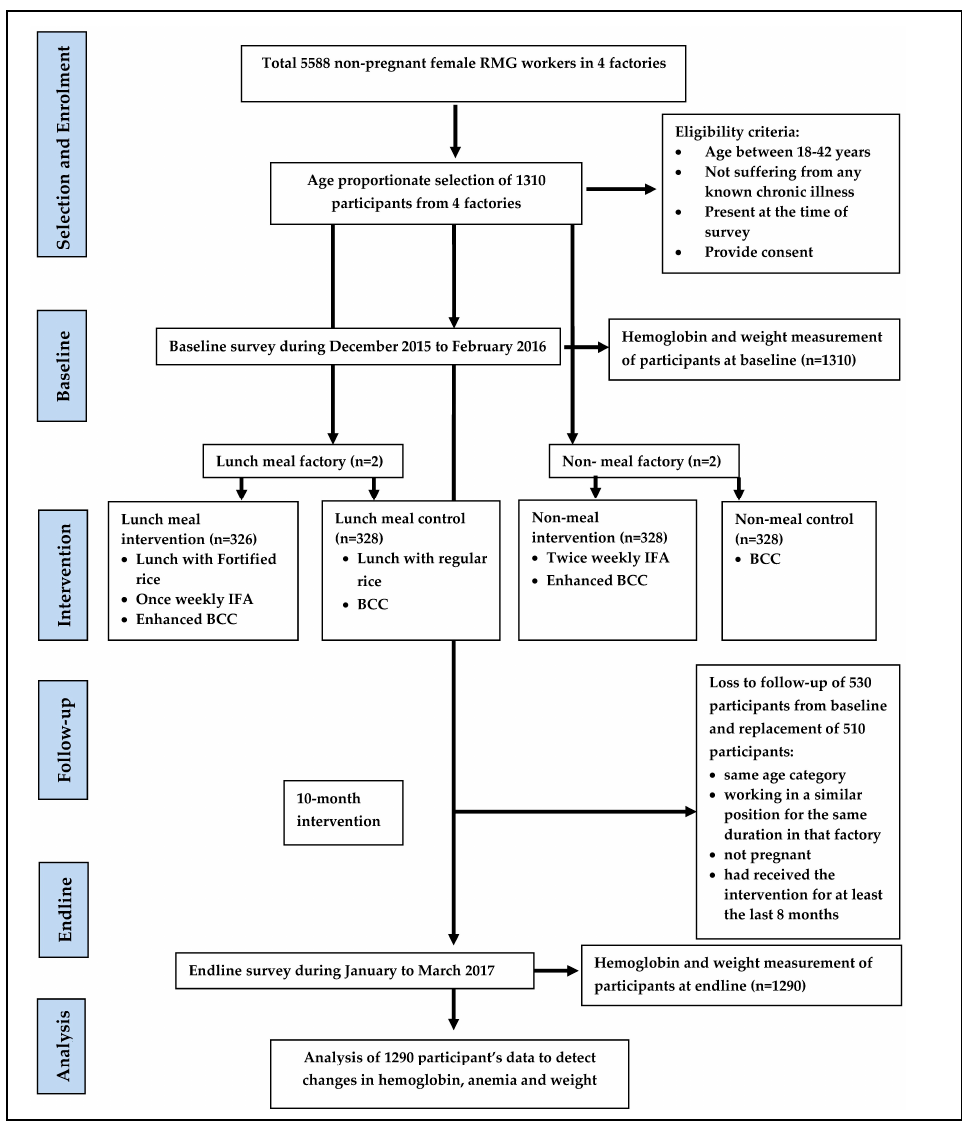
Figure 1. A flow chart of the study design.